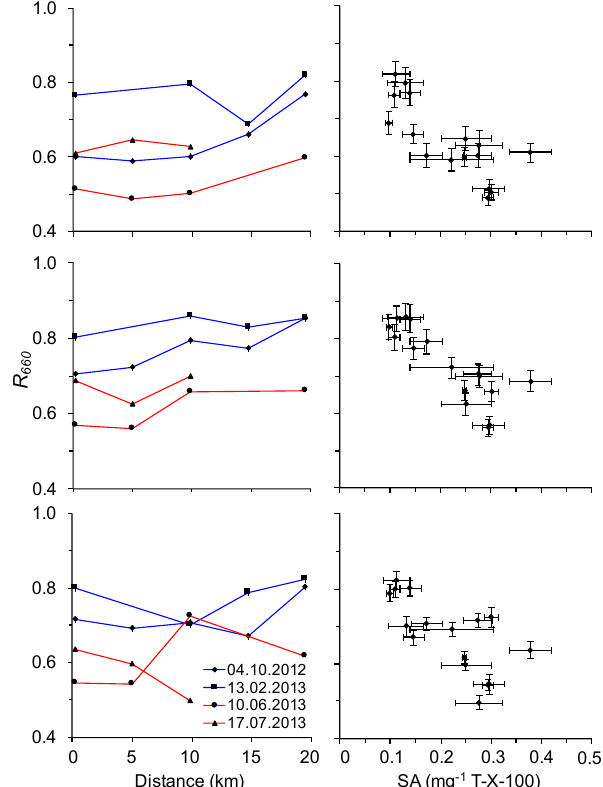
Figure 3. Left panels are R 660 for CH 4 in seawater samples col- lected along the Dove Time Series transect in the North Sea dur- ing 2012–2013. Right panels are scatter plots of the R 660 ( R 660 = k 660Sample /k 660Milli-Q ) and surfactant activity (SA) in the SML. The top two windows are for a tank baffle frequency of 0.6Hz, the two middle windows are for a tank baffle frequency 0.7Hz and bot- tom two windows are for a tank baffle frequency of